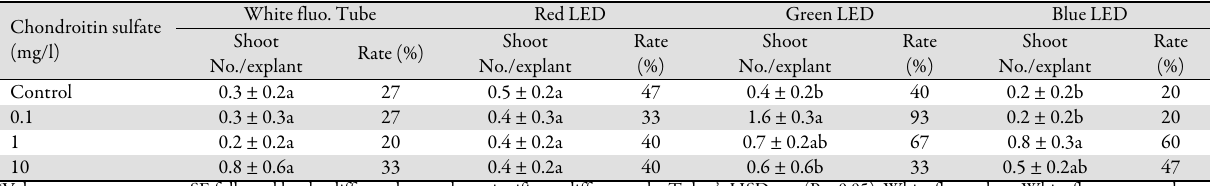
Table 4. In vitro growth of C. finlaysonianum shoots into different concentrations of chondroitin sulfate with modified MS medium, under four sources of lights Chondroitin sulfate (mg/l) 0.1